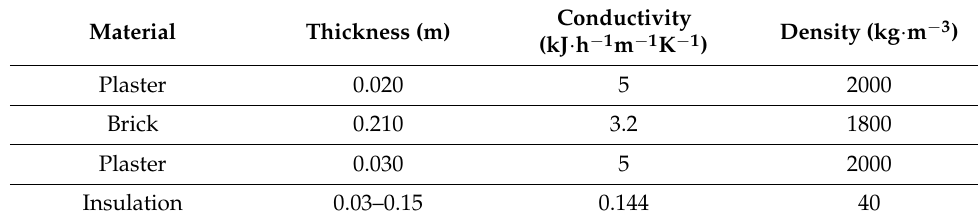
Table 1. Thermal properties of the external wall.